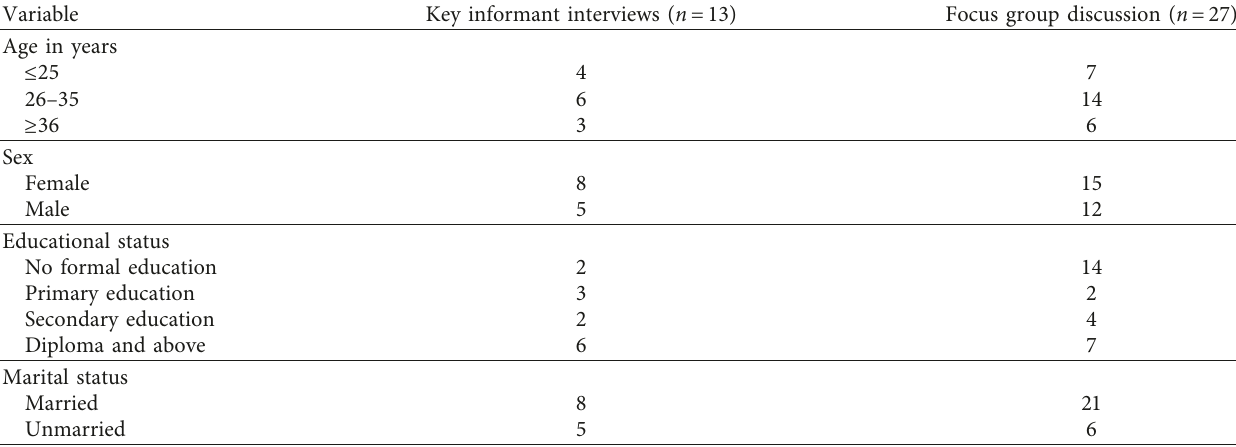
Table 2: Sociodemographic characteristics of qualitative study participants in the Gurage zone, southern Ethiopia, September to November